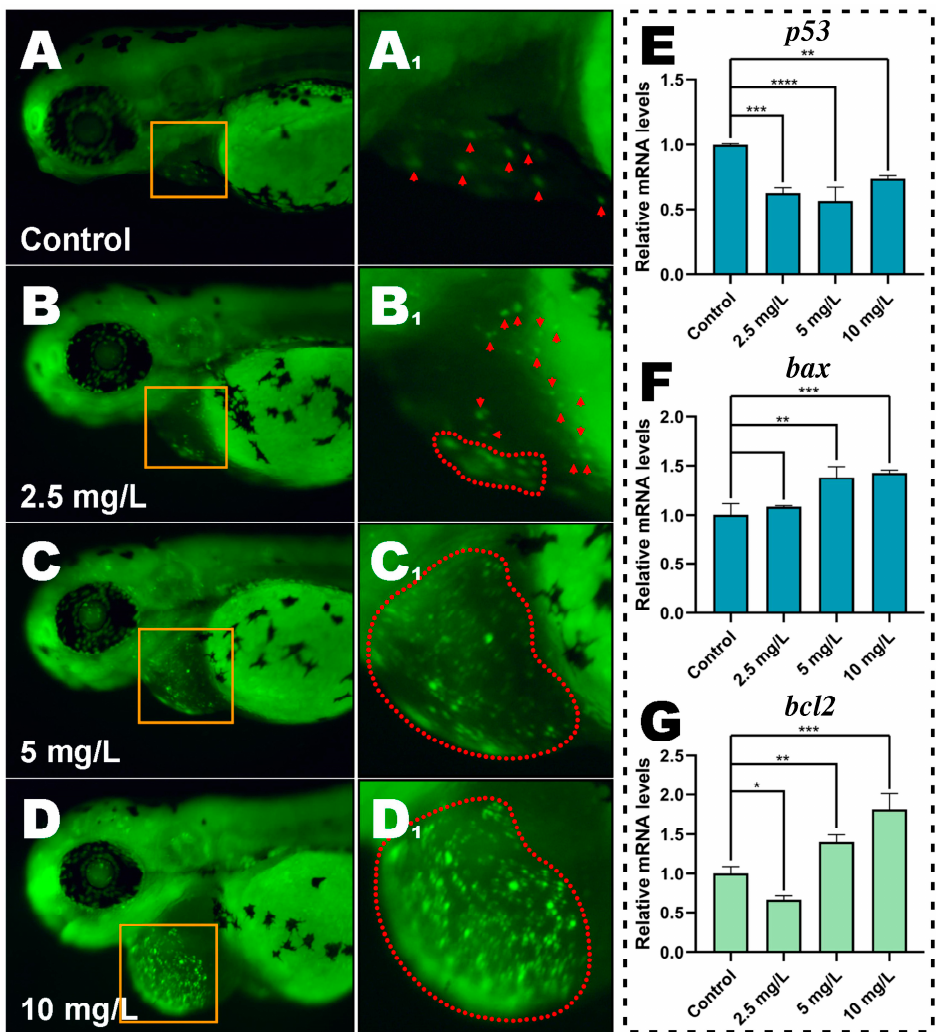
Figure 5. Methyl parathion induces apoptosis in zebrafish embryos at 72 hpf. ( A – D ) When the embryos were subjected to varied concentrations of MP after AO staining, the apoptotic cells revealed yellow-green, fluorescent patches. ( A1 ) is a magnified view of the yellow area in A, and so on for the rest. The yellow-green, fluorescent highlights (i.e., apoptotic cells) that need to be attended to are also indicated in the magnified view. The red arrows point to apoptotic cells, and the red dashed area indicates a large number of dense apoptotic cells. ( E – G ) Expression of apoptosis-related genes ( p53, bax, and bcl2 ) in embryos when exposed to MP at different concentrations (means ± S.D, * p < 0.05, ** p < 0.01, *** p < 0.001, **** p < 0.0001).